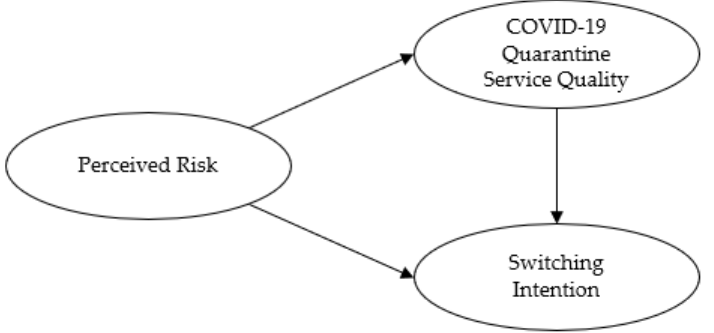
Figure 1. Theoretical framework on the relationship between perceived risk, COVID-19 quarantine service quality, and switching intention of on-site exhibition visitors